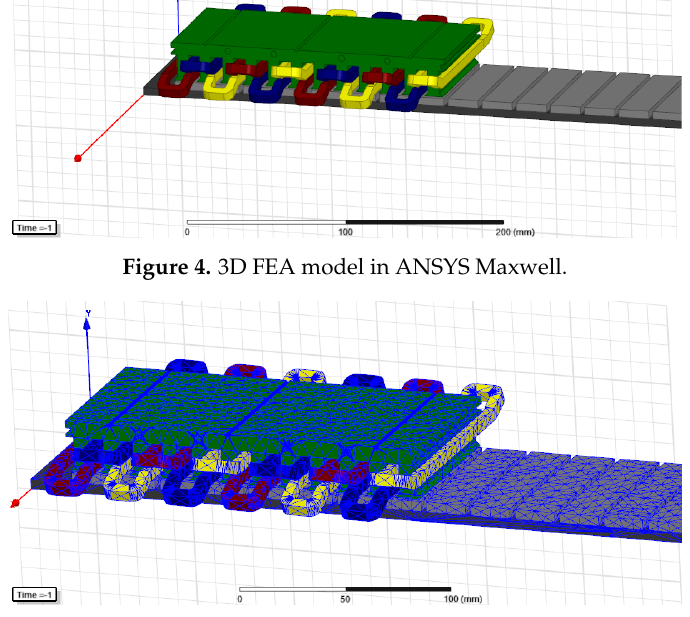
Figure 5. Mesh drawing of FEA